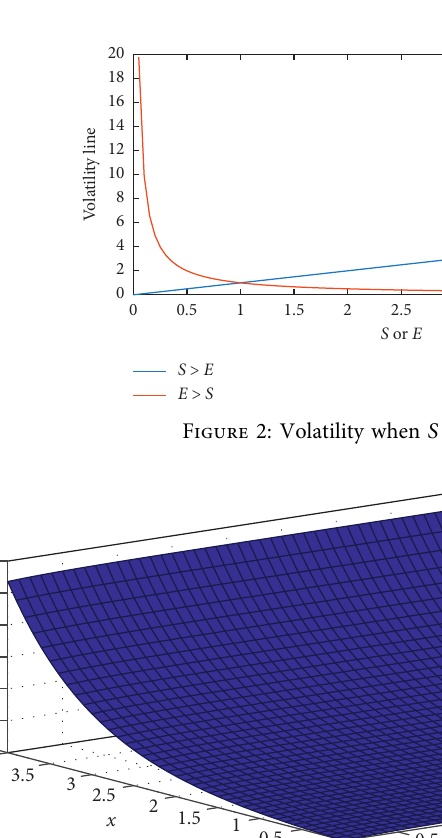
Figure 1: Volatility surface of the Black–Scholes equation.